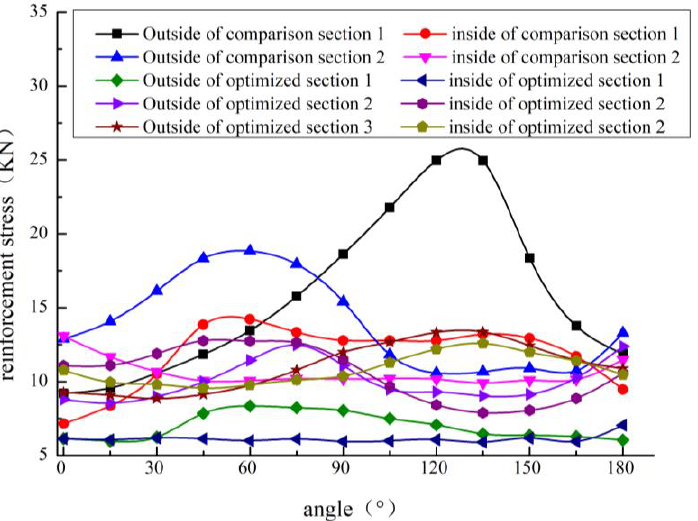
Figure 16. Comparison of axial force of reinforcement meter before and after adjustments.